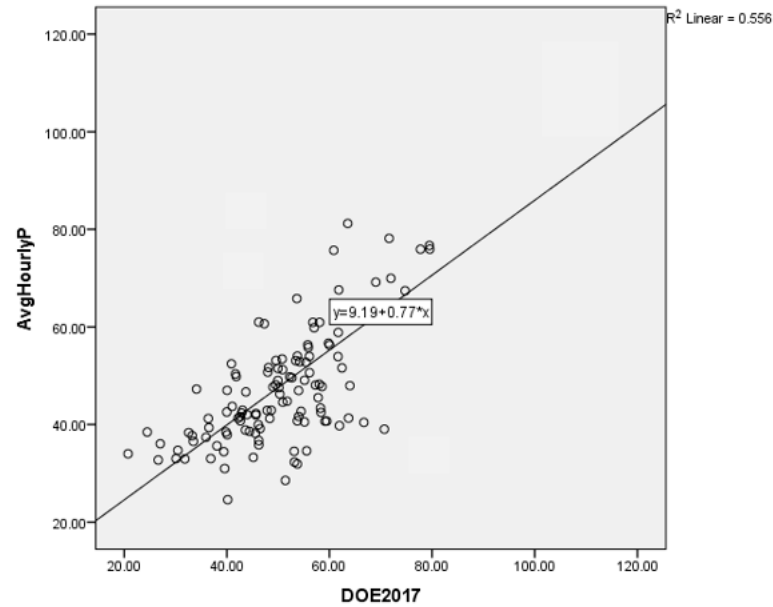
Figure 18. Regression of pollutant concentrations PM 2.5 prototype compared to DustTrak reference monitors. The linear regression equation is issued.